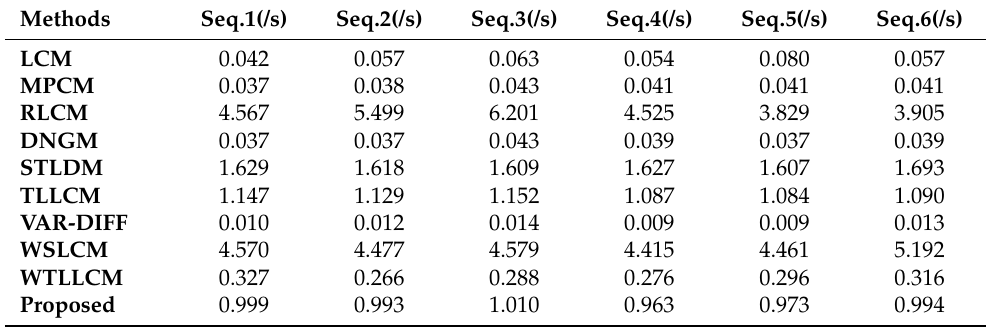
Table 5. Computation time of different methods.